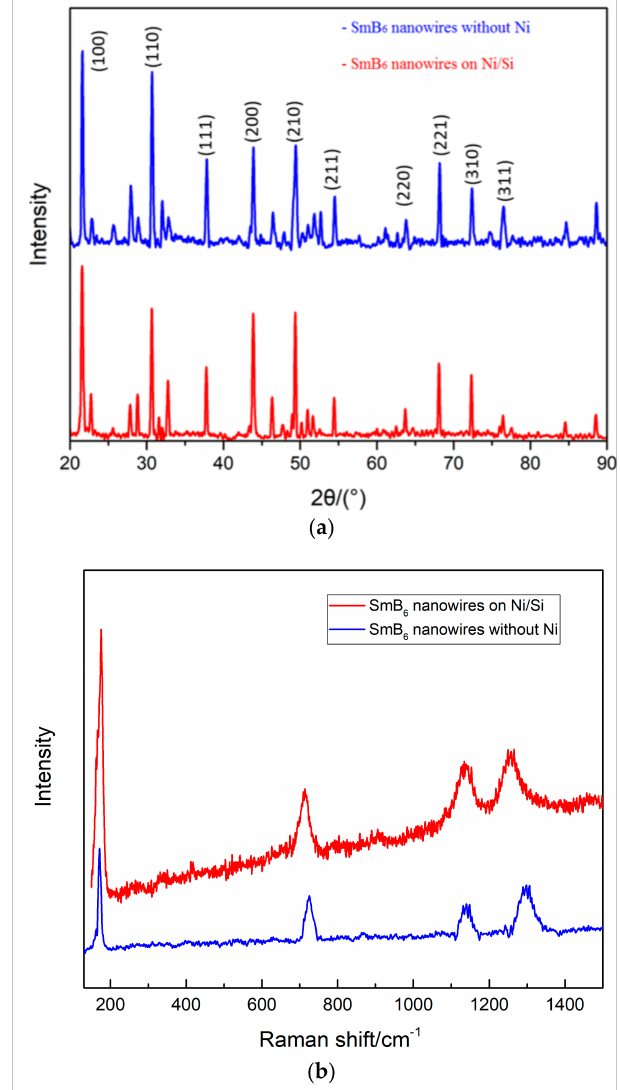
Figure 4. ( a ) XRD spectrum of SmB 6 nanowires grown with Ni catalyst, ( b ) Raman spectrum of SmB6 nanowires grown with Ni (top) and without Ni